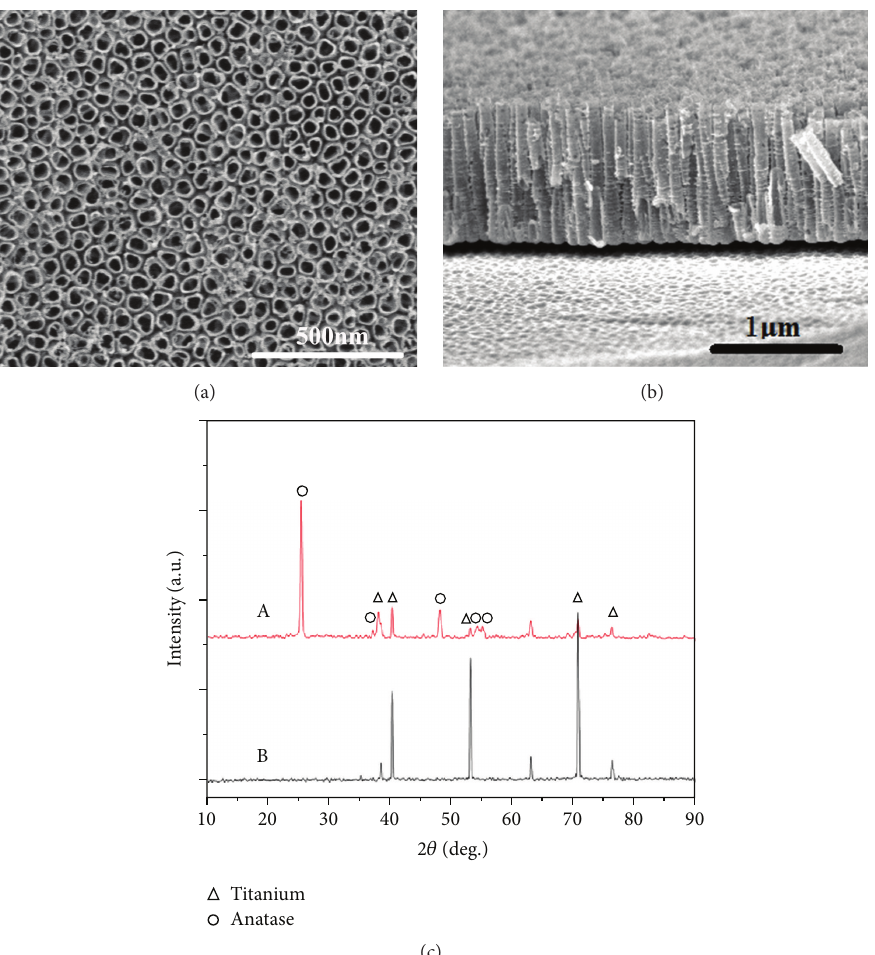
Figure 3: FE-SEM top-view (a) and cross-section (b) of TNAs electrode and (c) XRD patterns of TNAs